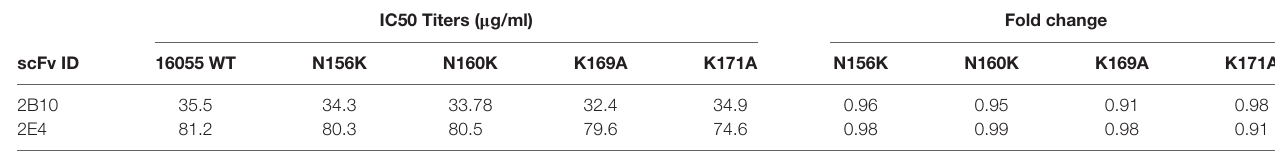
TaBle 4 | Assessment of V1V2 dependent neutralization activity of 2B10 and 2E4 scFvs.